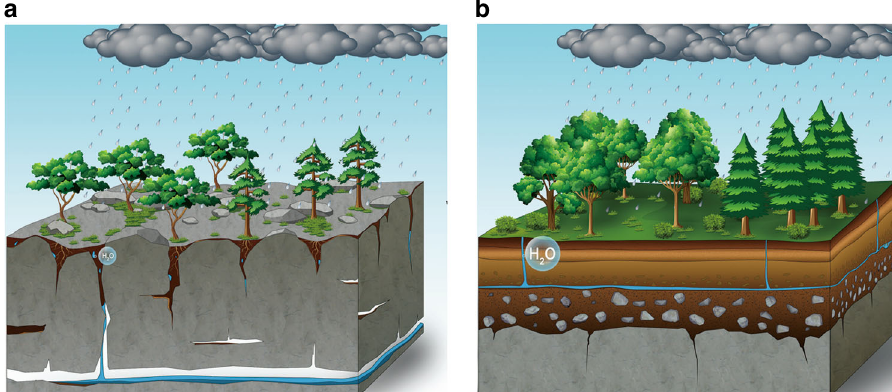
Fig. 1 Illustration of our hypothesis. a Karst critical zone structure; b non-karst critical zone structure; the bubble in the regolith represents the regolith water-holding capacity. We hypothesize that in the karst zone, the bedrock geochemistry can in fl uence vegetation productivity through controlling the regolith water hold capacity: increased Ca concentrations correspond to increased limestone, which is highly soluble, so the bedrock develops an amount of crevices. These properties limit the retention of water and hence affect the vegetation productivity. We expect that in karst regions, by regulating the regolith water-holding capacity, bedrock geochemistry plays an important role in the spatial variability in vegetation